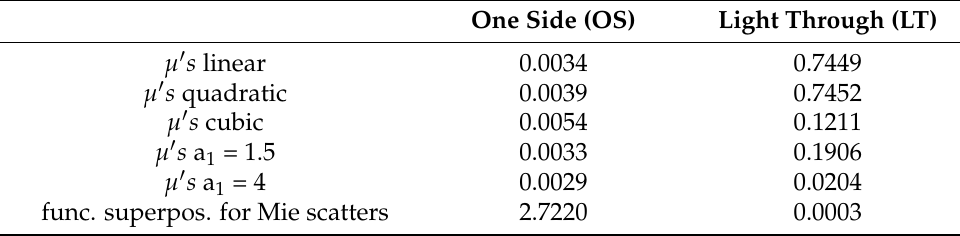
Table 1. The magnitude of the discrepancy (error) between the model and experimental spectra.